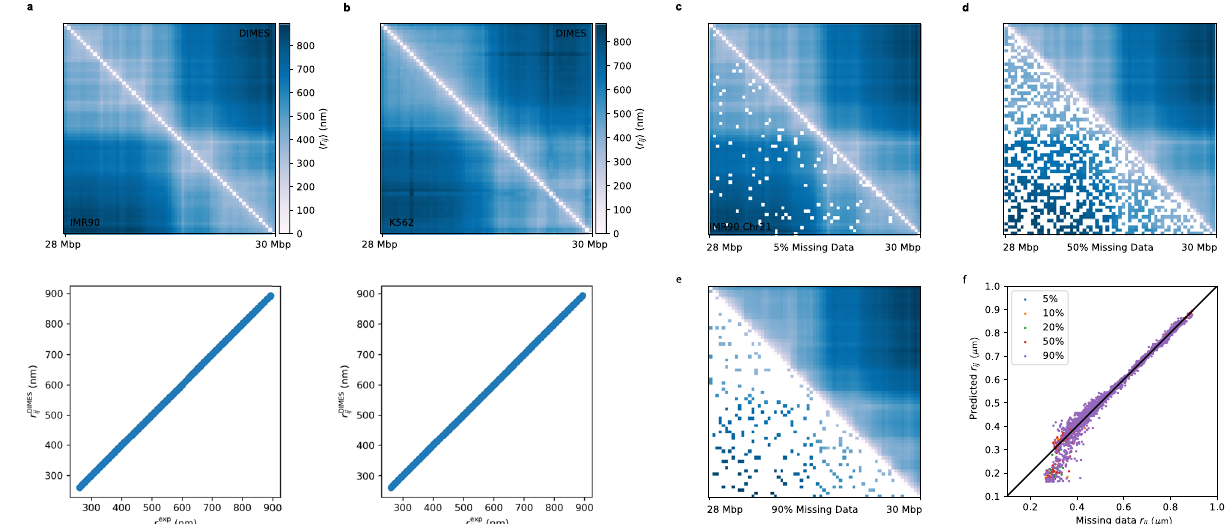
Fig. 2 | Effectiveness of DIMES in matching the targets generated using experimental imaging data. Comparison between the mean spatial distances computed from the reconstructed structures and the experimental data in cell lines: IMR90 ( a ), K562 ( b ), A549 (Supplementary Fig. 10a), and HCT116 (Supple- mentaryFig.10b).Theupperpanelshowsside-by-sidecomparisonsofthedistance matrices, and the lowerpaneldisplays thescatter plot between individualpairwise